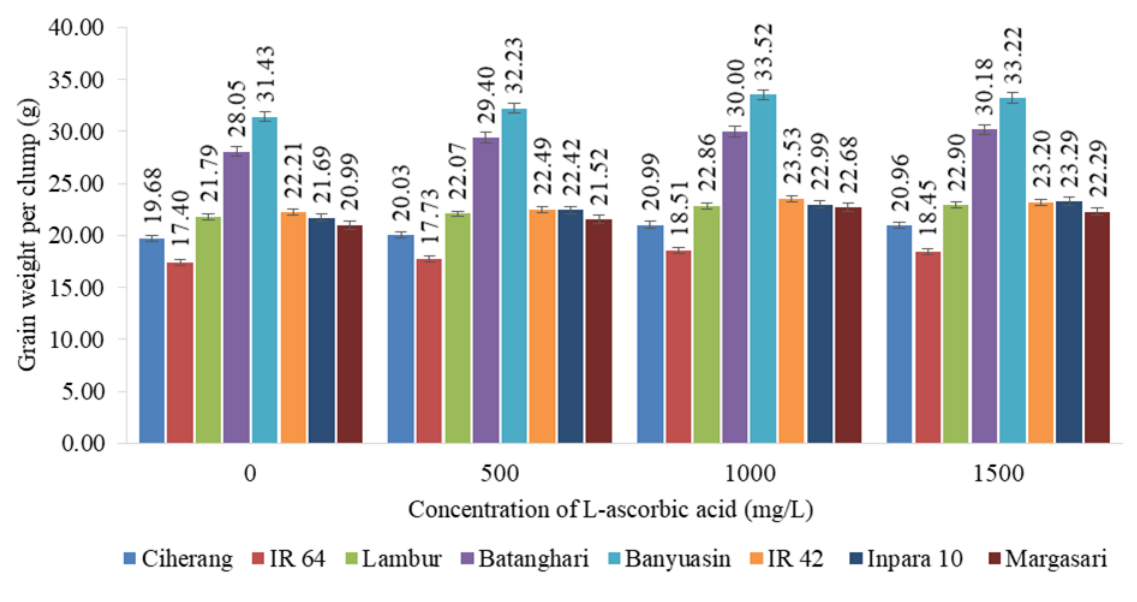
Figure 3 Effect of -ascorbic acid treatment on the grain weight per clump of eight rice varieties grown under salinity stress. e mean values followed by different letters indicate significant difference between treatments according to Duncan’s